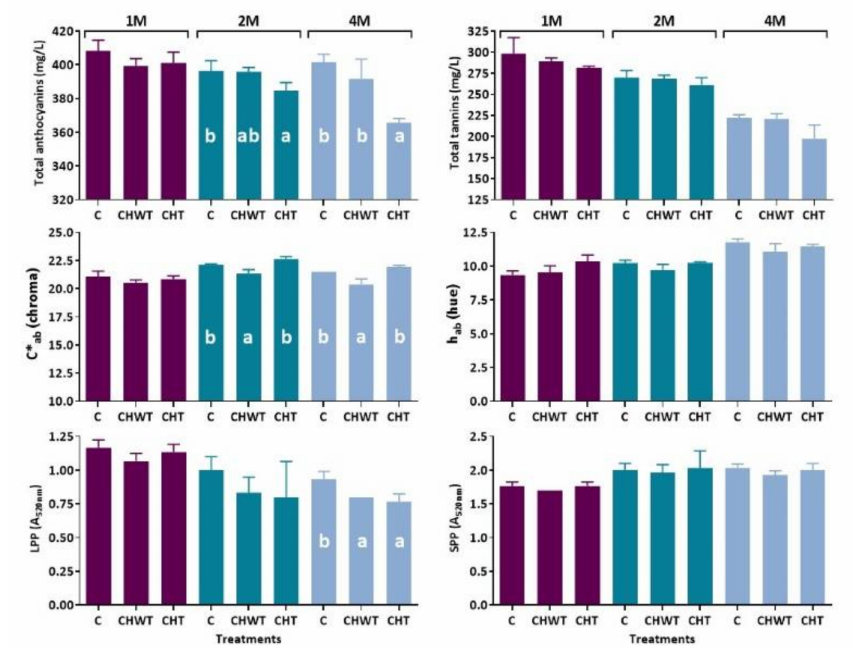
Figure 5. Global phenolic compositions and color parameters of Malbec wines obtained by applying vine-shoots during aging. Different letters for each aging time indicate significant differences between treatments (Tukey’s HSD test, p < 0.05). C, control; CHWT, untoasted vine-shoot chips; CHT, toasted vine-shoot chips; 1M, 30 days; 2M, 60 days; 4M, 120 days; SPP, small polymeric pigments; LPP, large polymeric